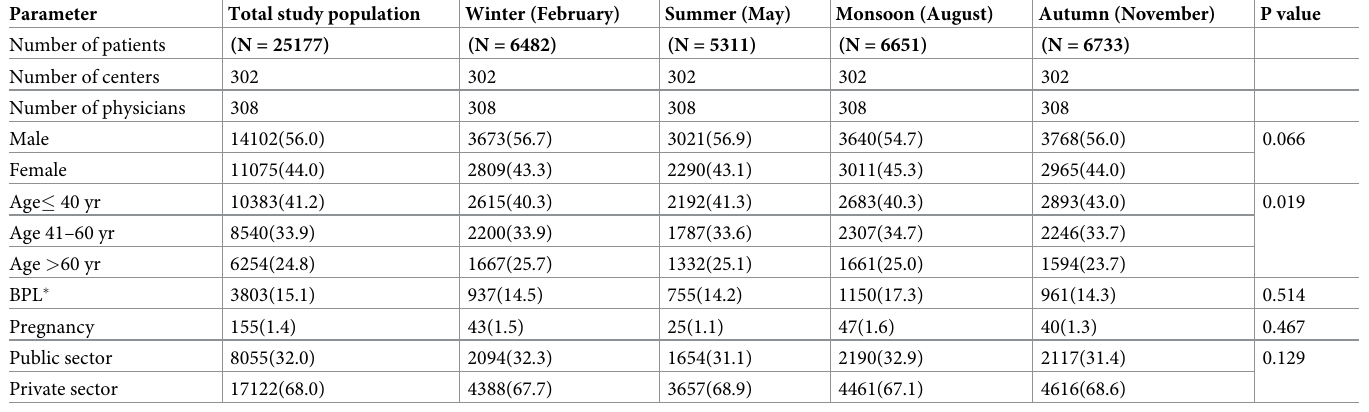
Table 1. Number of patients, demographic factors, healthcare settings and presenting